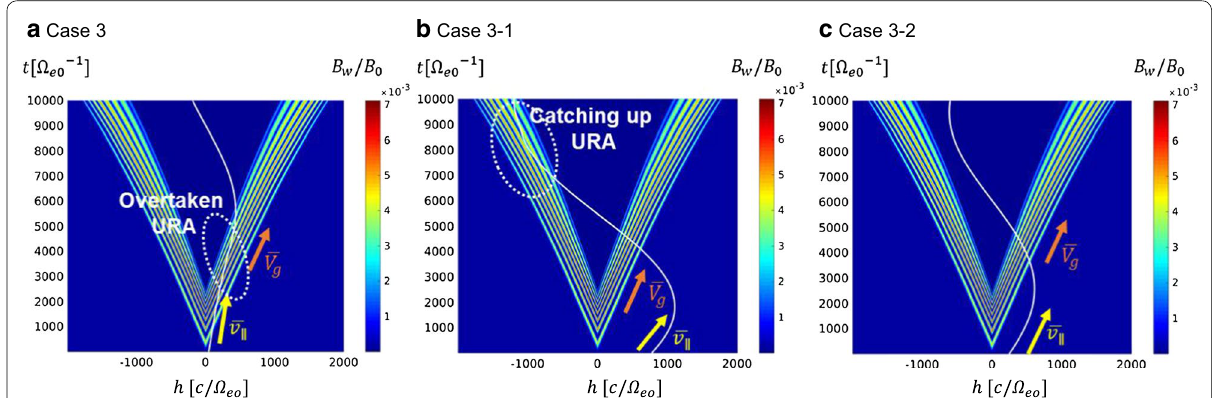
Fig. 8 Different types of the URA acceleration depending on the interrelation between v and V g . a Trajectory of the most successful electron in (cid:31) case 3 (5.7 MeV-86°) is again taken as an example. The electron travels slower than the chorus wave propagation ( v < V g ). The electron is accelerated (cid:31) by URA when it is overtaken by the chorus wave approaching from the behind (overtaken URA). b Trajectory in case 3-1 (5.7 MeV-62°). The electron travels with the velocity v > V g , and is accelerated by URA when it catches up with the chorus wave going ahead (catching up URA). c Trajectory (cid:31) V g and is neither overtaken nor catching up with the chorus wave, thus the efficient URA in case 3-2 (5.7 MeV-74°). The electron travels with v � ≈ acceleration does not